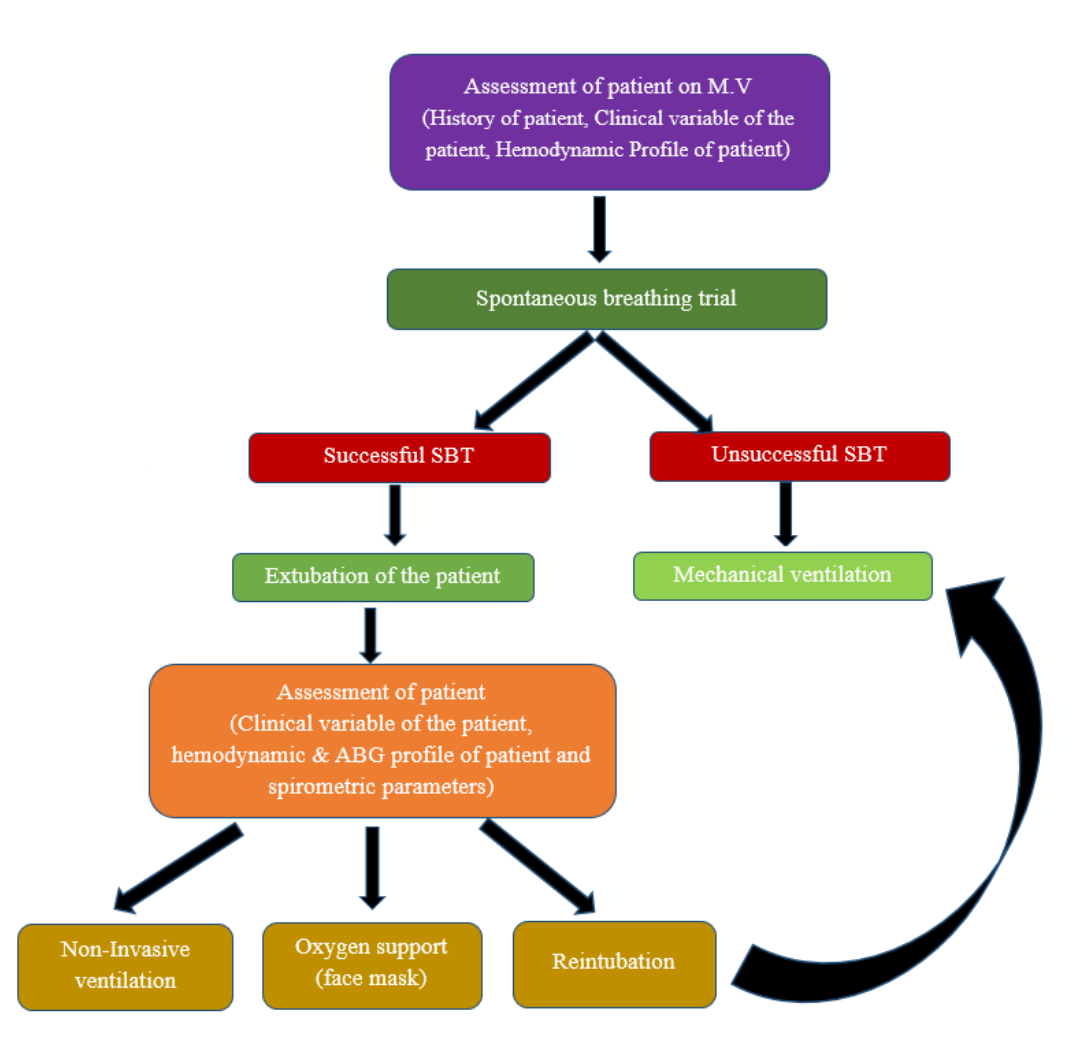
Figure 1: Schematic diagram of self-constructed Conceptual